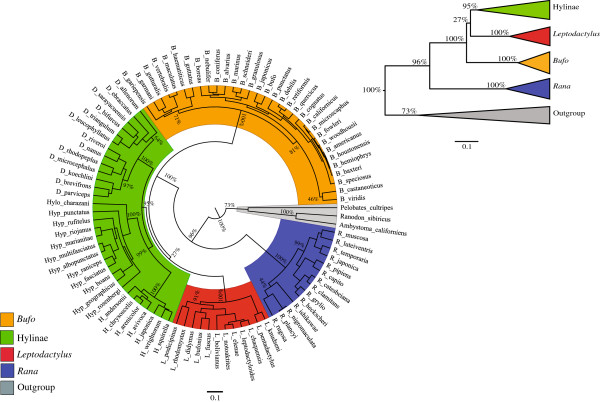
Polar Bayesian phylogenetic tree under the GTR+Γ+I evolution model based on 12S mtDNA sequences from 90 species belonging to four clades of anurans (Bufo, Hylinae, Leptodactylus and, Rana). Bayesian posterior supports for major nodes are shown. The scale bar indicates a branch length equivalent to 0.1 nucleotide substitutions per site. Abbreviations: B: Bufo; D: Dendropsophus; H: Hyla; Hylo: Hyloscirtus; Hyp: Hypsiboas; L: Leptodactylus; R: Rana.